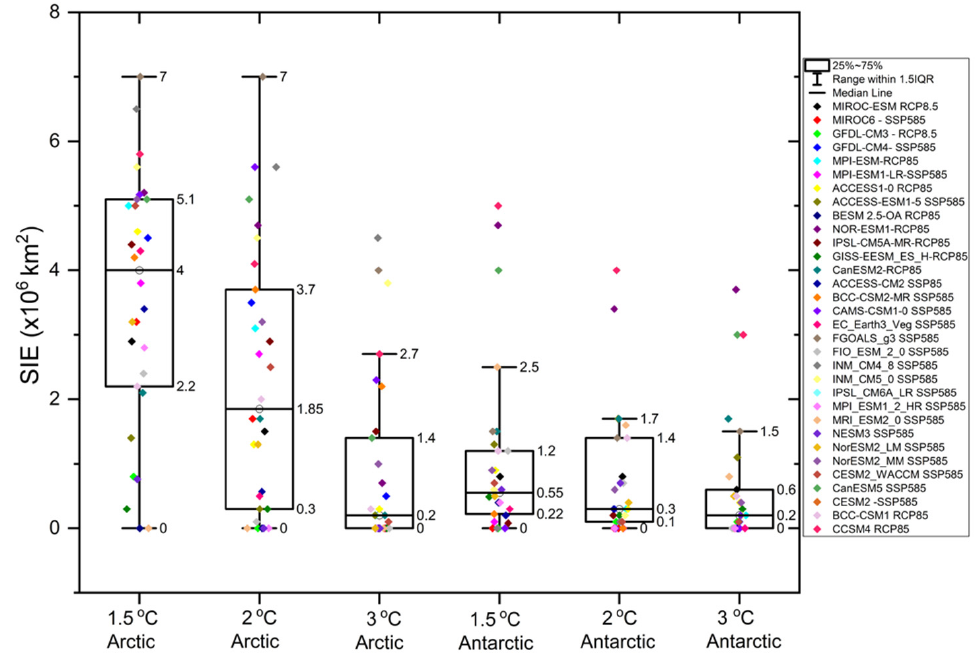
Figure 6. Arctic and Antarctic SIE summer minimum considering the temperature threshold of +1.5 ◦ C, 2.0 ◦ C and 3.0 ◦ C global mean warming under RCP8.5 and SSP585 scenarios. The Arctic’s (Antarctica’s) summer minimum occurs in September